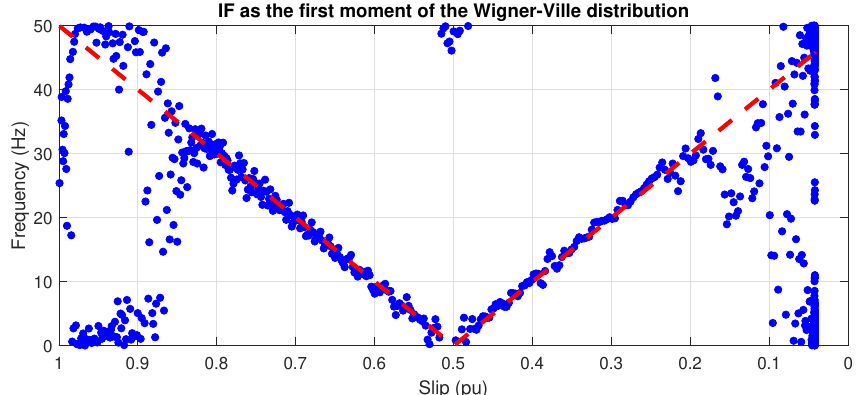
Figure 5. Instantaneous frequency of the LSHst in the slip–frequency plane, obtained from the WVD. Dashed, red line: theoretical evolution of the fault harmonic. Blue dots: evolution of the LSHst of the simulated machine.